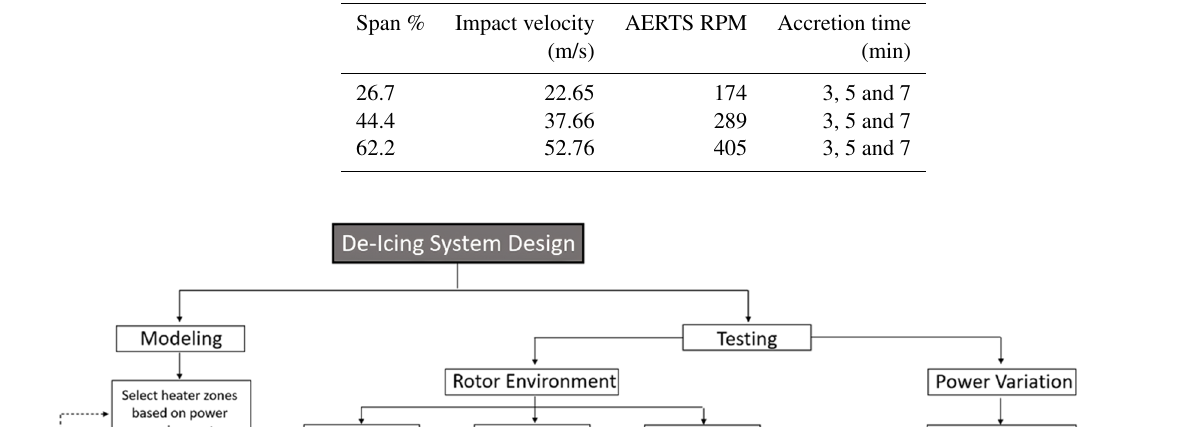
Table 1. Linear ice accretion test matrix.